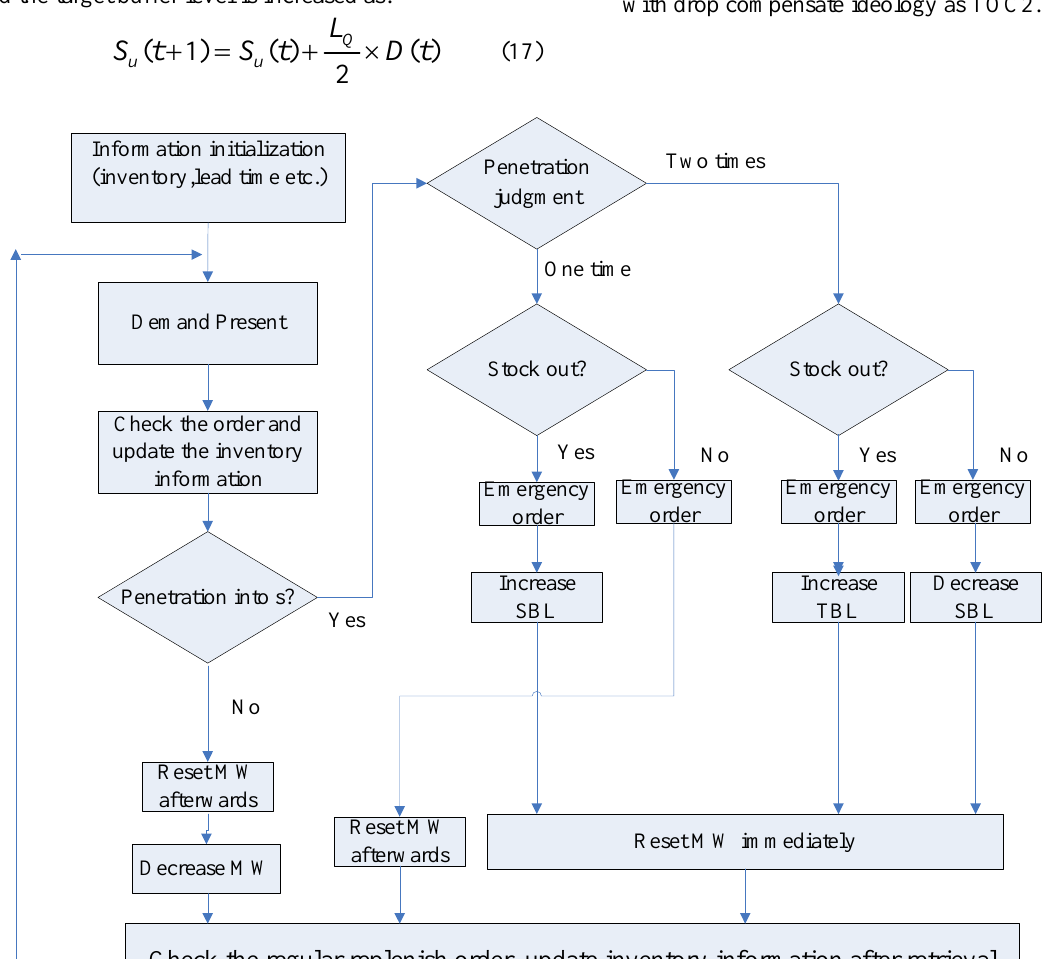
Fig.4. Adjust procedure of the inventory control system based on